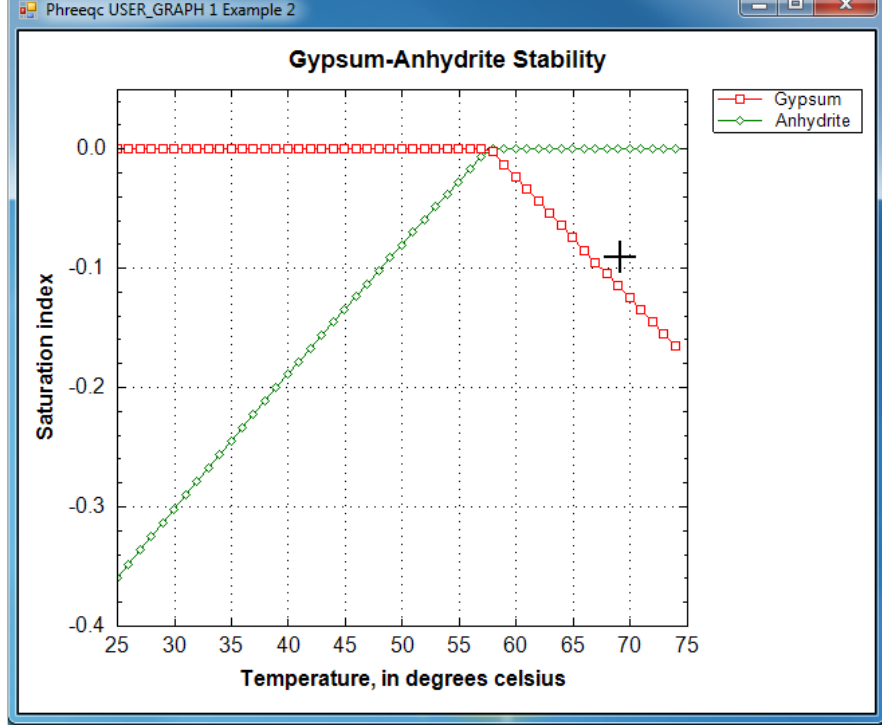
Figure 4. Saturation indices of gypsum and anhydrite in water that has equilibrated with the more stable of the two phases over the temperature range 25 to 75 °C.